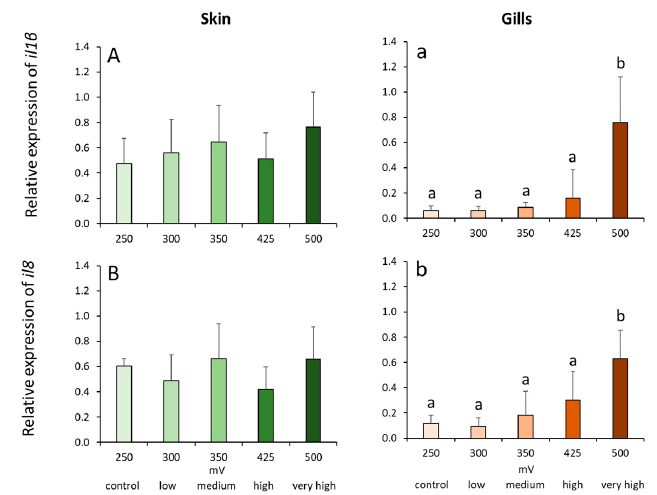
Figure 5. Relative expression of cytokine genes in the skin ( A , B ) and gills ( a , b ) of Atlantic salmon exposed to varying ORP levels. Values are presented as mean and standard deviation of 6 individual fish per treatment group. Different letters denote significant difference between treatments at p < 0.05. Ozone treatment significantly affected the expression of hsp70 in the skin but not in the gills (Figure 6A,a). Hsp70 transcript level was significantly elevated in medium and very high groups compared with the control and low groups (Figure 6A). From the 3 apoptosis-related genes, only the expression of bax was significantly impacted by the treatments in both tissues (Figure 6B,b). Cutaneous expression was highest in the very high group, and the transcript level was significantly higher compared with all the other groups except with the high group (Figure 6B). The expression of bax in the medium, high and very high groups was significantly elevated compared with the control but not with the low group (Figure 6b). Varying ozone doses did not significantly alter the expression of casp3a and casp7 in both tissues (Figure 6C,c,D,d).